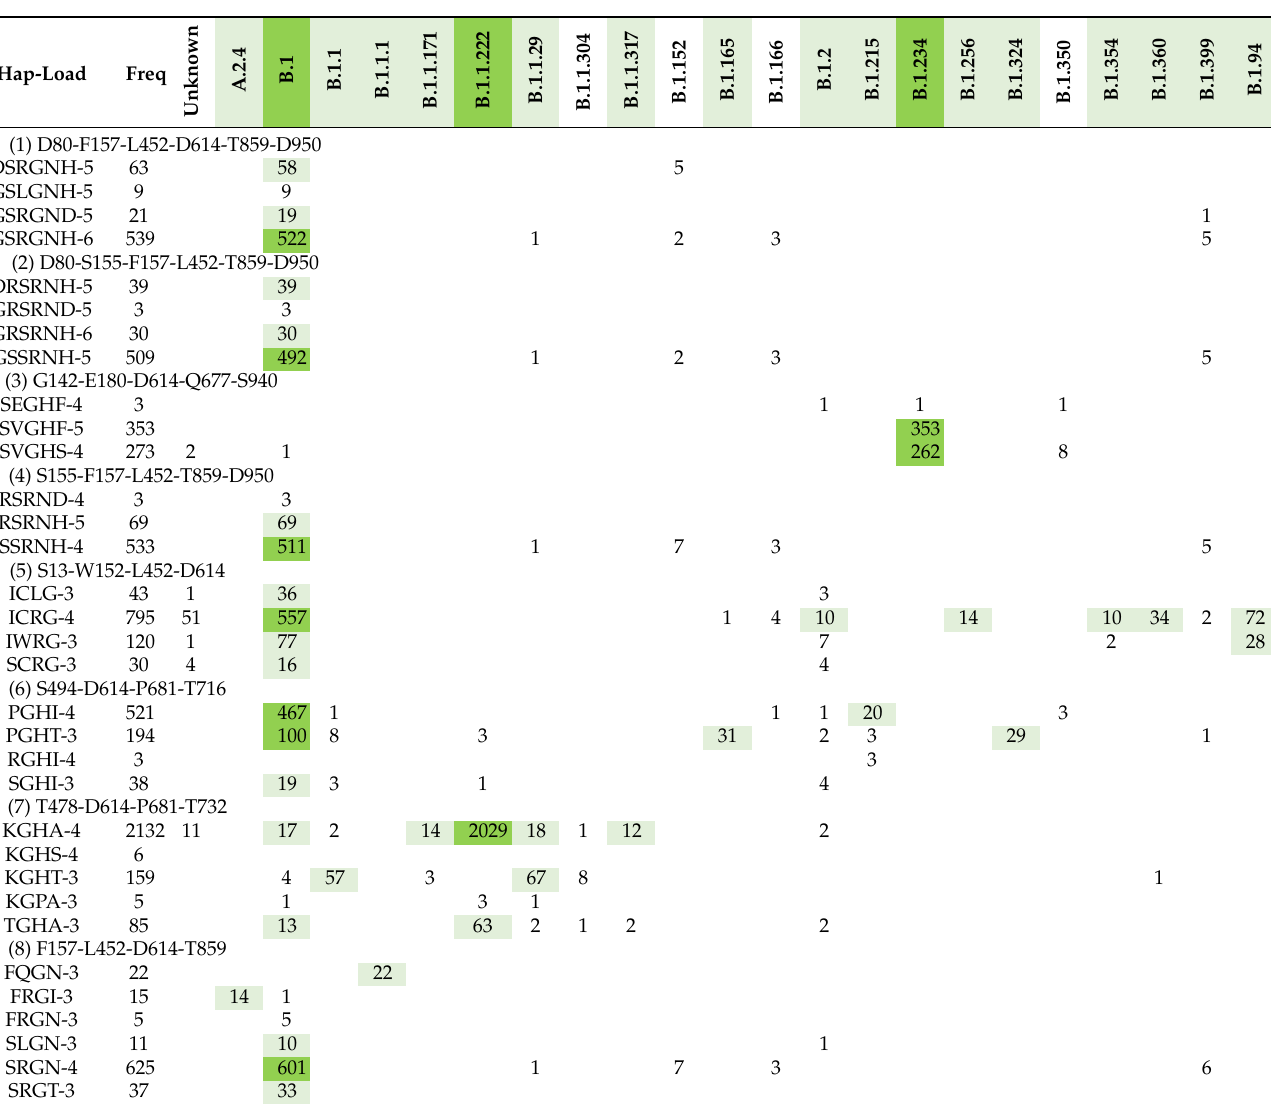
Table 3. VRV-haplotypes. Cross-tabulation of individual VRV-haplotypes with GISAID-assigned lineages in all 167,893 sequences, excluding lineages with fewer than 10 occurrences. “Freq”, corre- sponding haplotype frequencies; “Unknown”, sequences not assigned to any lineage.